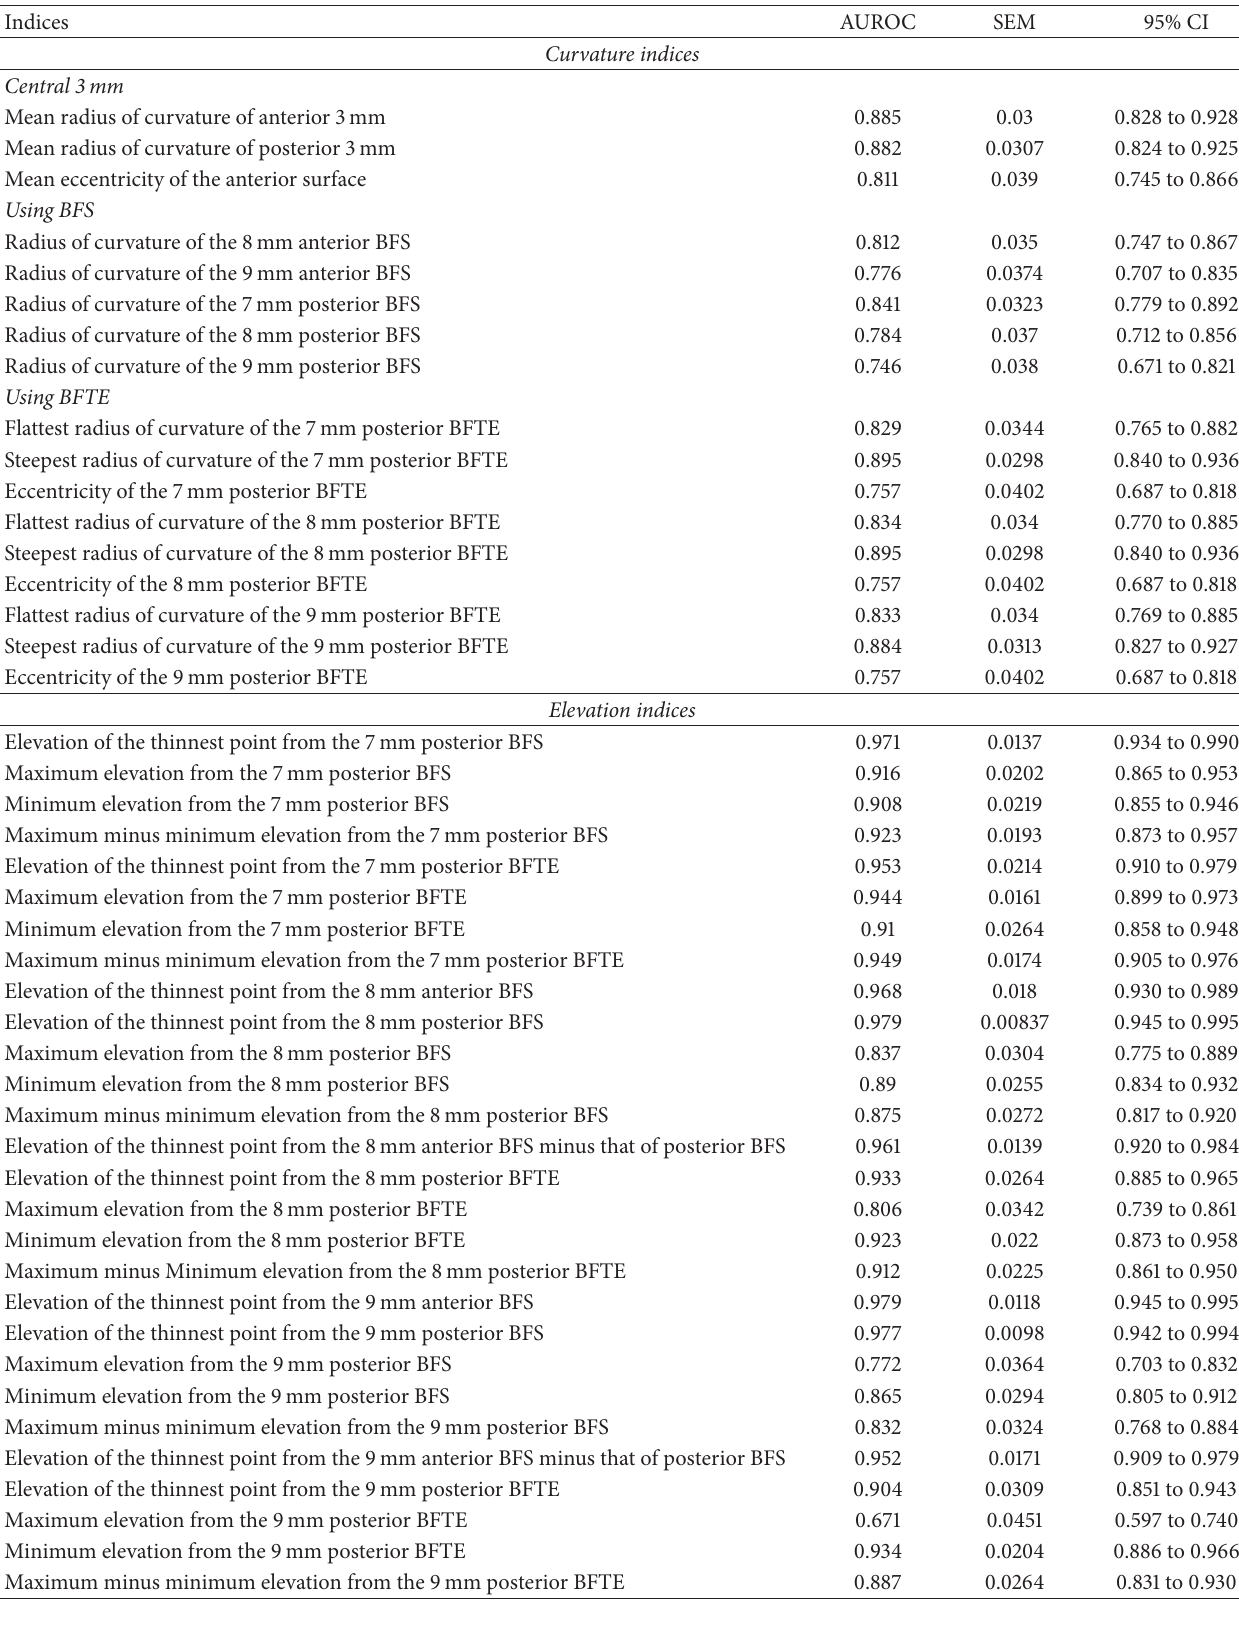
Table 2: AUROC of all indices when differentiating all grades of KC collectively from normal